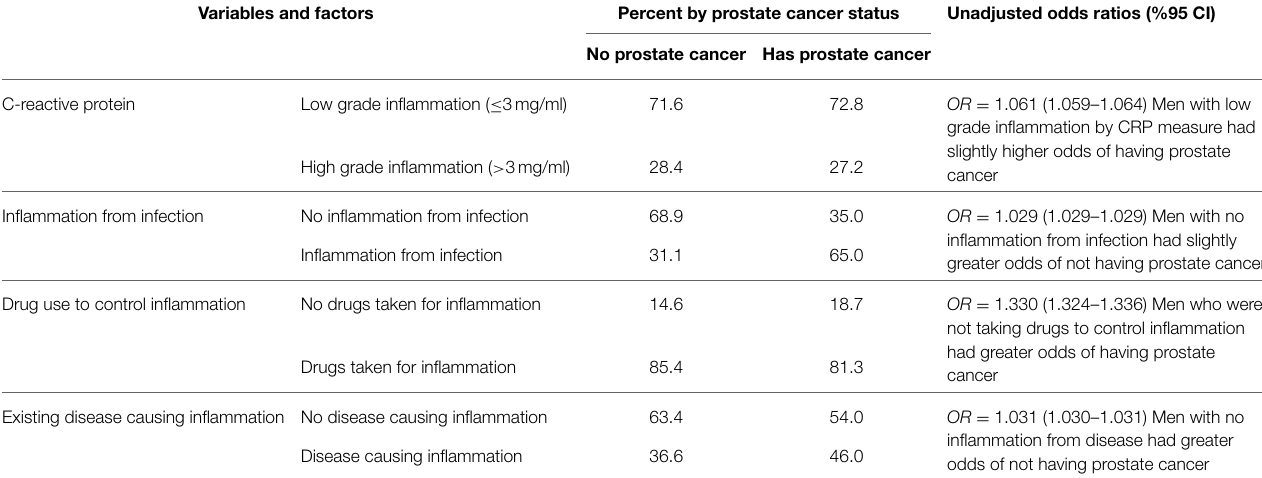
TABLE 2 | Inflammation covariates by prostate cancer status, 2009–2010 NHANES data. Variables and